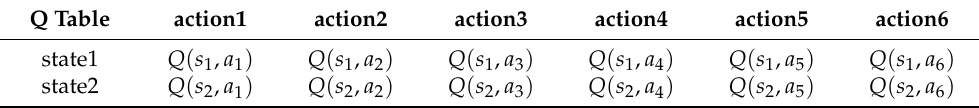
Table 2. The form of the Q table. Q